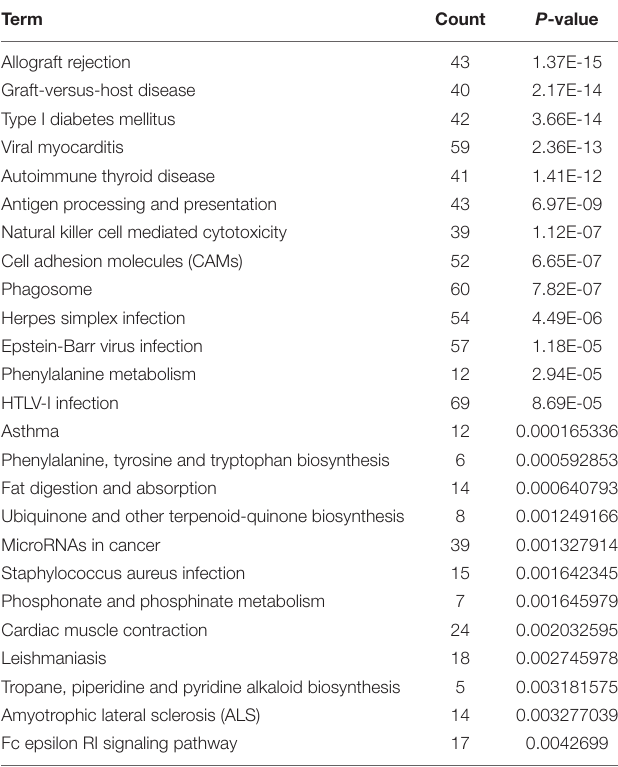
TABLE 4 | Pathway enrichment of the target genes of differentially expressed lncRNAs. Term Count P